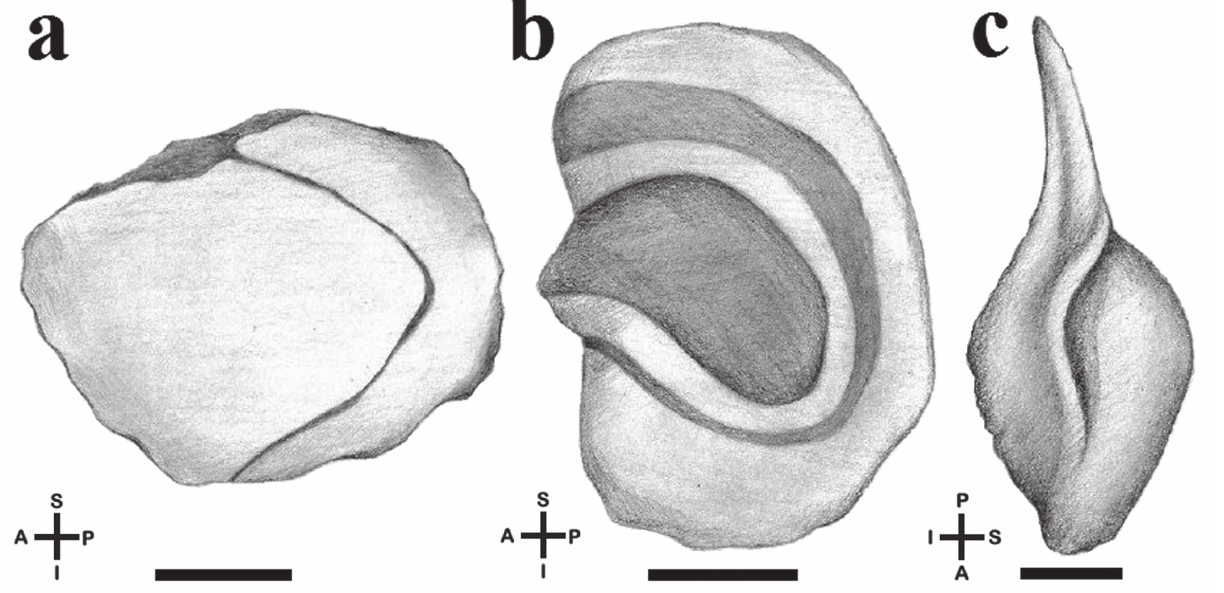
Fig. 9. Right serie of Hypostomus paranensis otoliths of (a) Lapillus, Scale bar = 200 µm; (b) Asteriscus, Scale bar = 200 µm; (c) Sagitta, Scale bar = 200